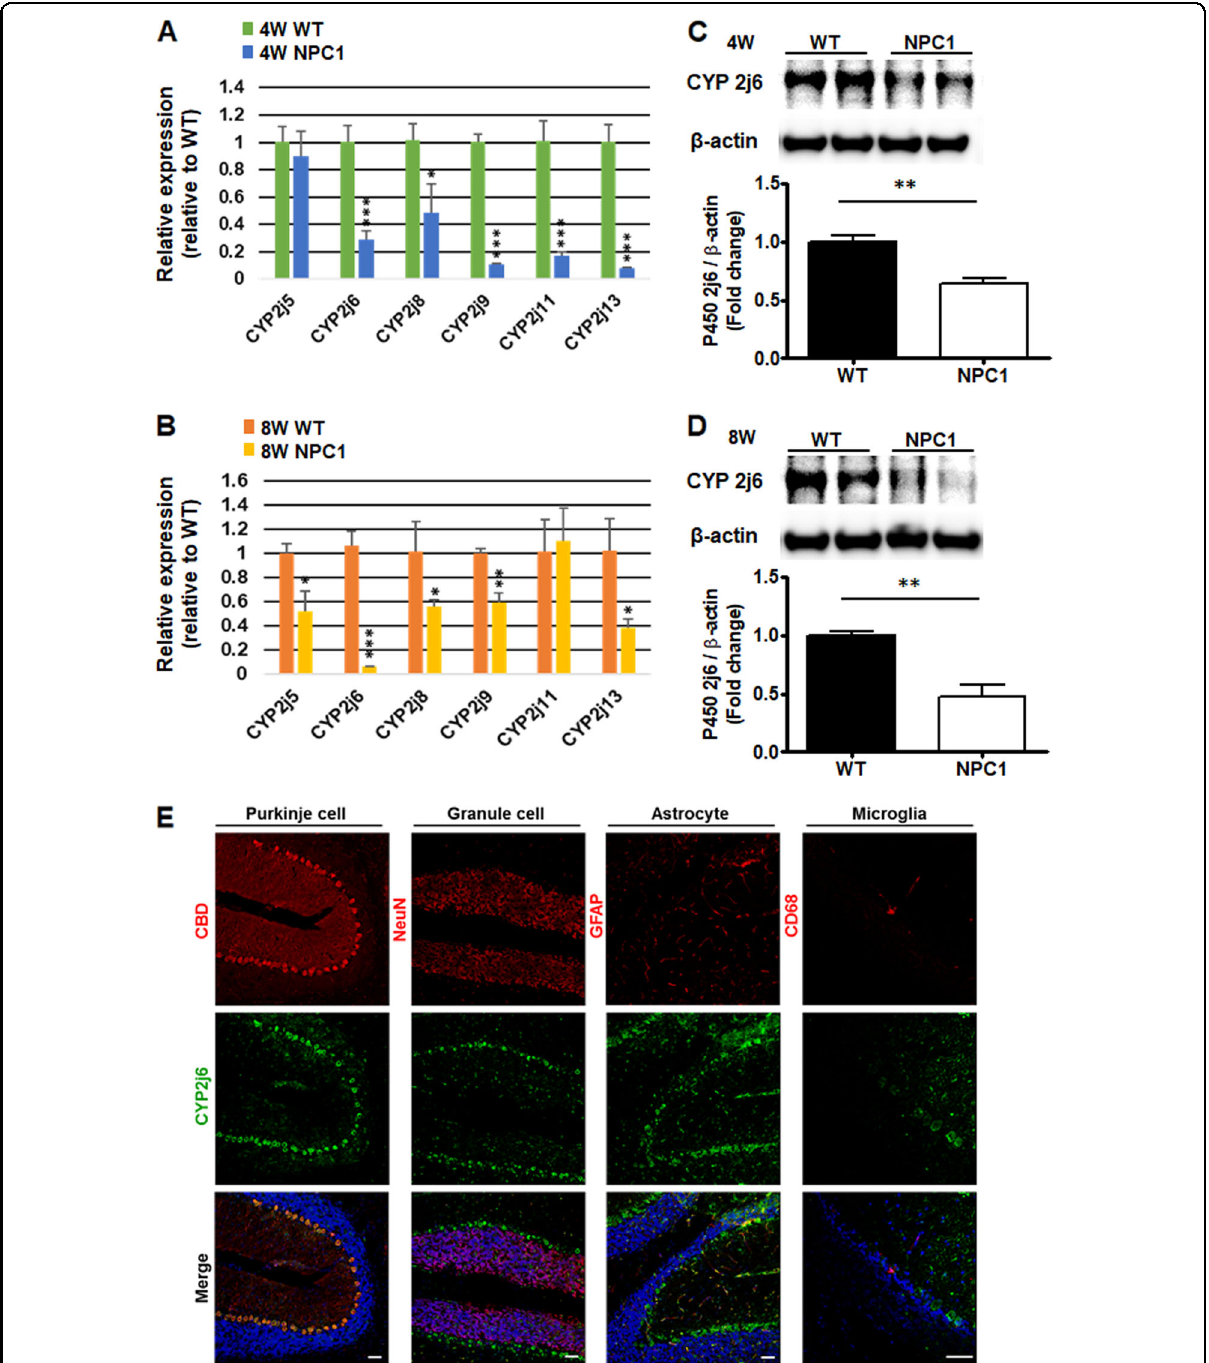
Fig. 3 Expression of CYP2J subfamilies in WT and NPC1-mutant mice. a The expression levels of CYP2J subfamily genes were quanti fi ed at 4 weeks of age and b 8 weeks of age from WT and NPC1-mutant mouse cerebella (NPC1). c Immunoblot analysis with anti-CYP2J6 antibodies at 4 weeks of age and d 8 weeks of age from WT and NPC1-mutant mouse cerebella. e Immunohistochemistry analysis of the co-localization of CYP2J6 (CYP2J6; green) with Purkinje cells (calbindin; red), granule cells (NeuN; red), astrocytes (GFAP; red), and microglia (CD68; red) in WT cerebella. Nuclei were counterstained with DAPI. Experiments were conducted in triplicate as the mean ± SD. Scale bars = 50 μ m. * P < 0.05; ** P < 0.01; *** P <